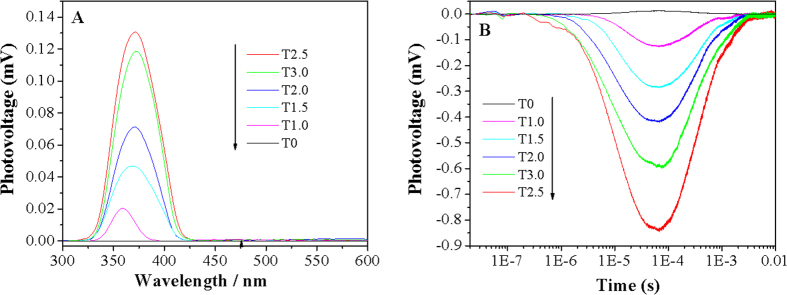
SS-SPS (A) and TR-SPV (B) responses of different TiO2 samples in N2 atmosphere.